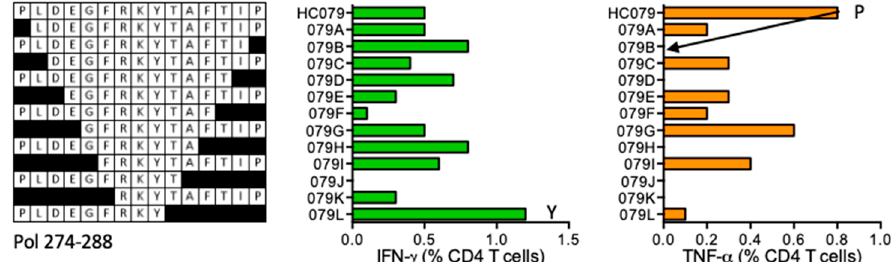
Figure 5. HC079 / VID 417—definition of CD4 + T-cell epitopes in HIV-1 protein Pol. HC078 STCL was generated using cryopreserved PBMC of volunteer 417 and tested against truncated peptides (left) in ICS. IFN- γ (green) and TNF- α (orange) producing CD4 + T cells were enumerated. Arrows and amino acid Y and P indicate the stimulatory peptide